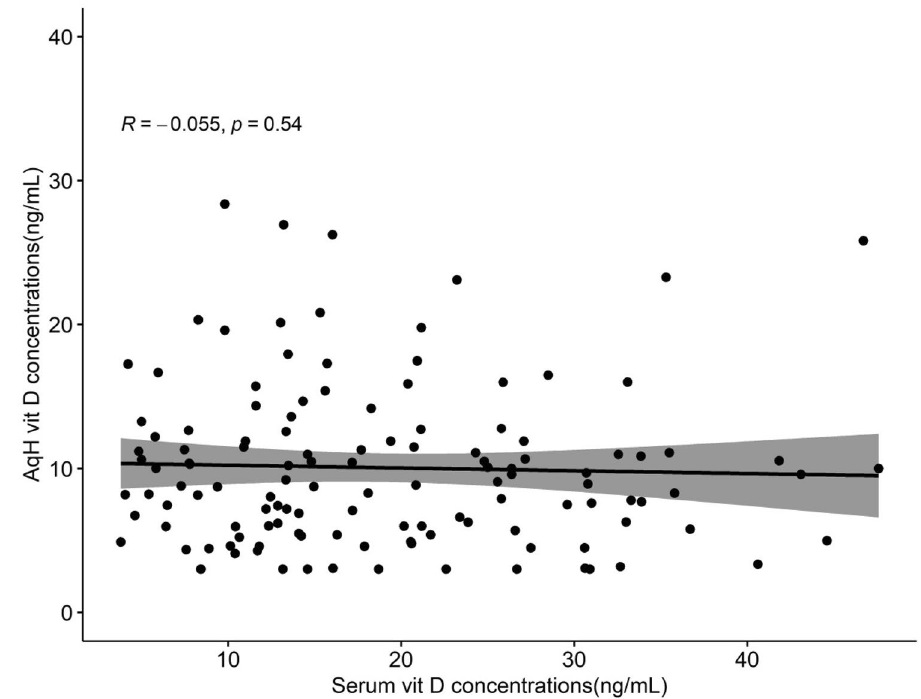
Figure 2. The correlation plot between serum and aqueous 25(OH)D levels of all patients. AqH = aqueous humor; vit D = vitamin D.